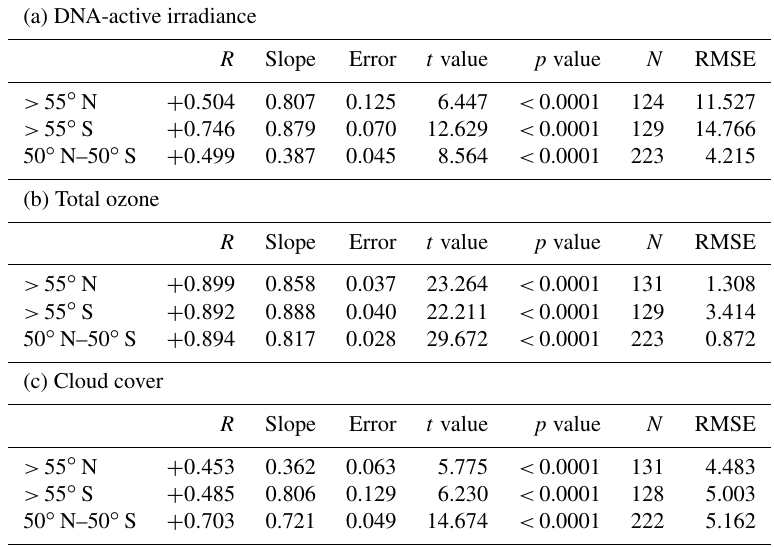
Table 2. (a) Correlation results between model simulations (HIS-SD) and ground-based DNA-active irradiance data for the northern high- latitude stations ( > 55 ◦ N), the southern high-latitude stations ( > 55 ◦ S), and the stations between 50 ◦ N–50 ◦ S. (b) Same as (a) but for the HIS-SD simulation and satellite SBUV (v8.7) total-ozone data. (c) Same as (a) but for the HIS-SD simulation and satellite MODIS Terra cloud fraction data. Error, t value, and p value refer to slope; t value should be higher than 2.576 for 99% statistical